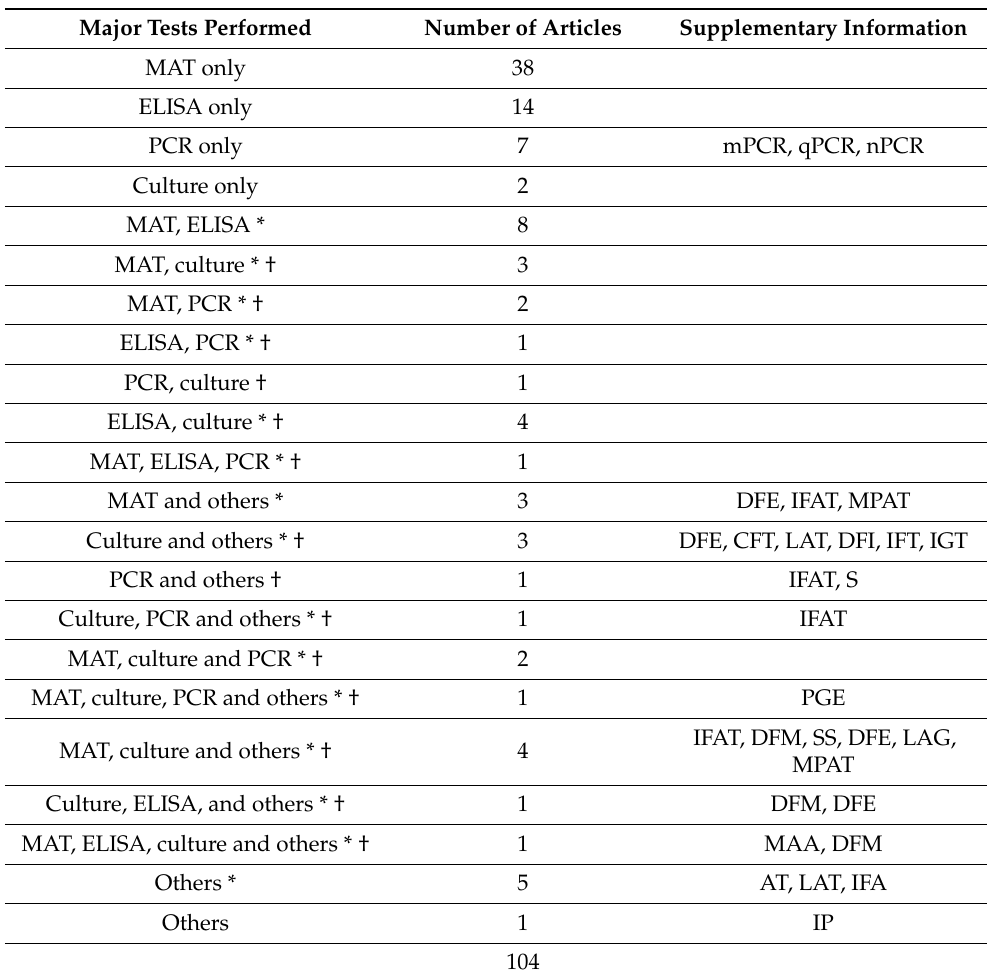
Table 3. Methods of detection performed in 104 publications (research articles and case studies) in the Middle